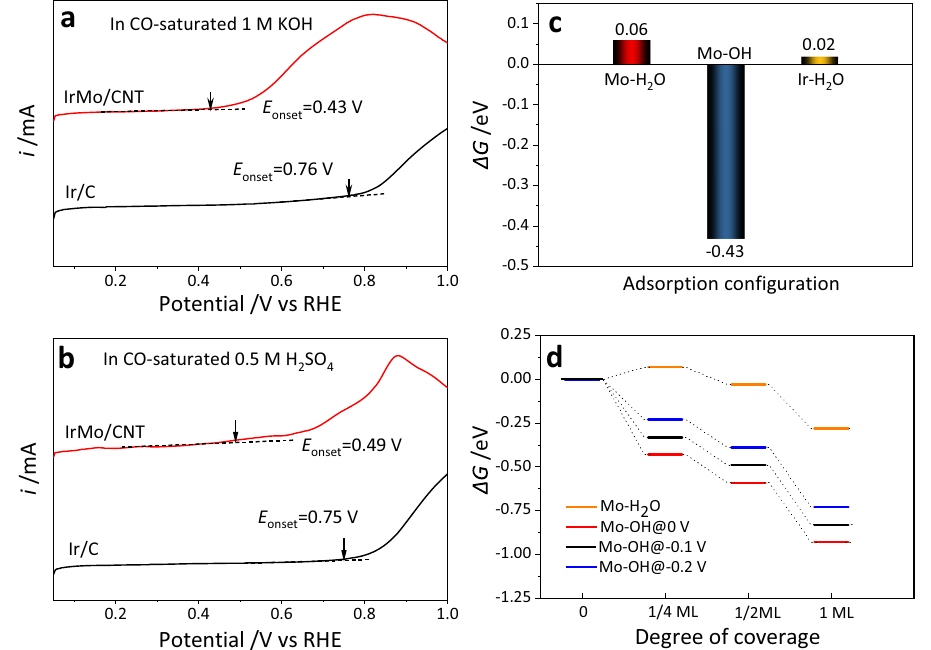
Fig. 5 | Surface structure of IrMo model. a , b LSV curves of IrMo/CNT and Ir/C in CO-saturated 1M KOH ( a ) and 0.5M H 2 SO 4 ( b ) with a scan rate of 50mVs − 1 . The anodecurrentinthesecurvesrepresentstheCOoxidizationcurrent.Thepositions marked by arrows indicate the onsetpotentialof CO oxidization. c The adsorption